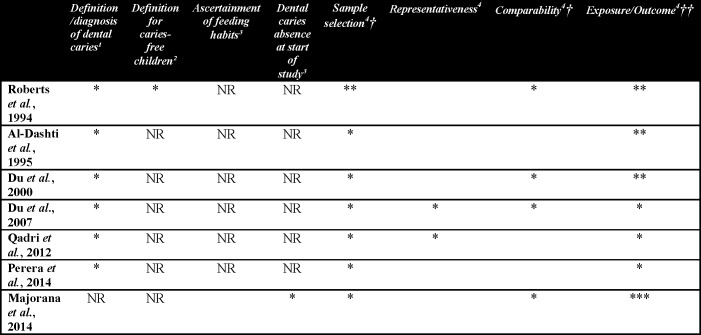
Newcastle-Ottawa quality assessment summary.
1For cross-sectional and case-control studies. 2For case-control study only. 3For cohort study only. 4For all study designs. †This item was allocated a maximum of 2 points. †† This item was allocated a maximum of 2 point for cross-sectional and 3 points for cohort and case-control studies. NR = not rated.